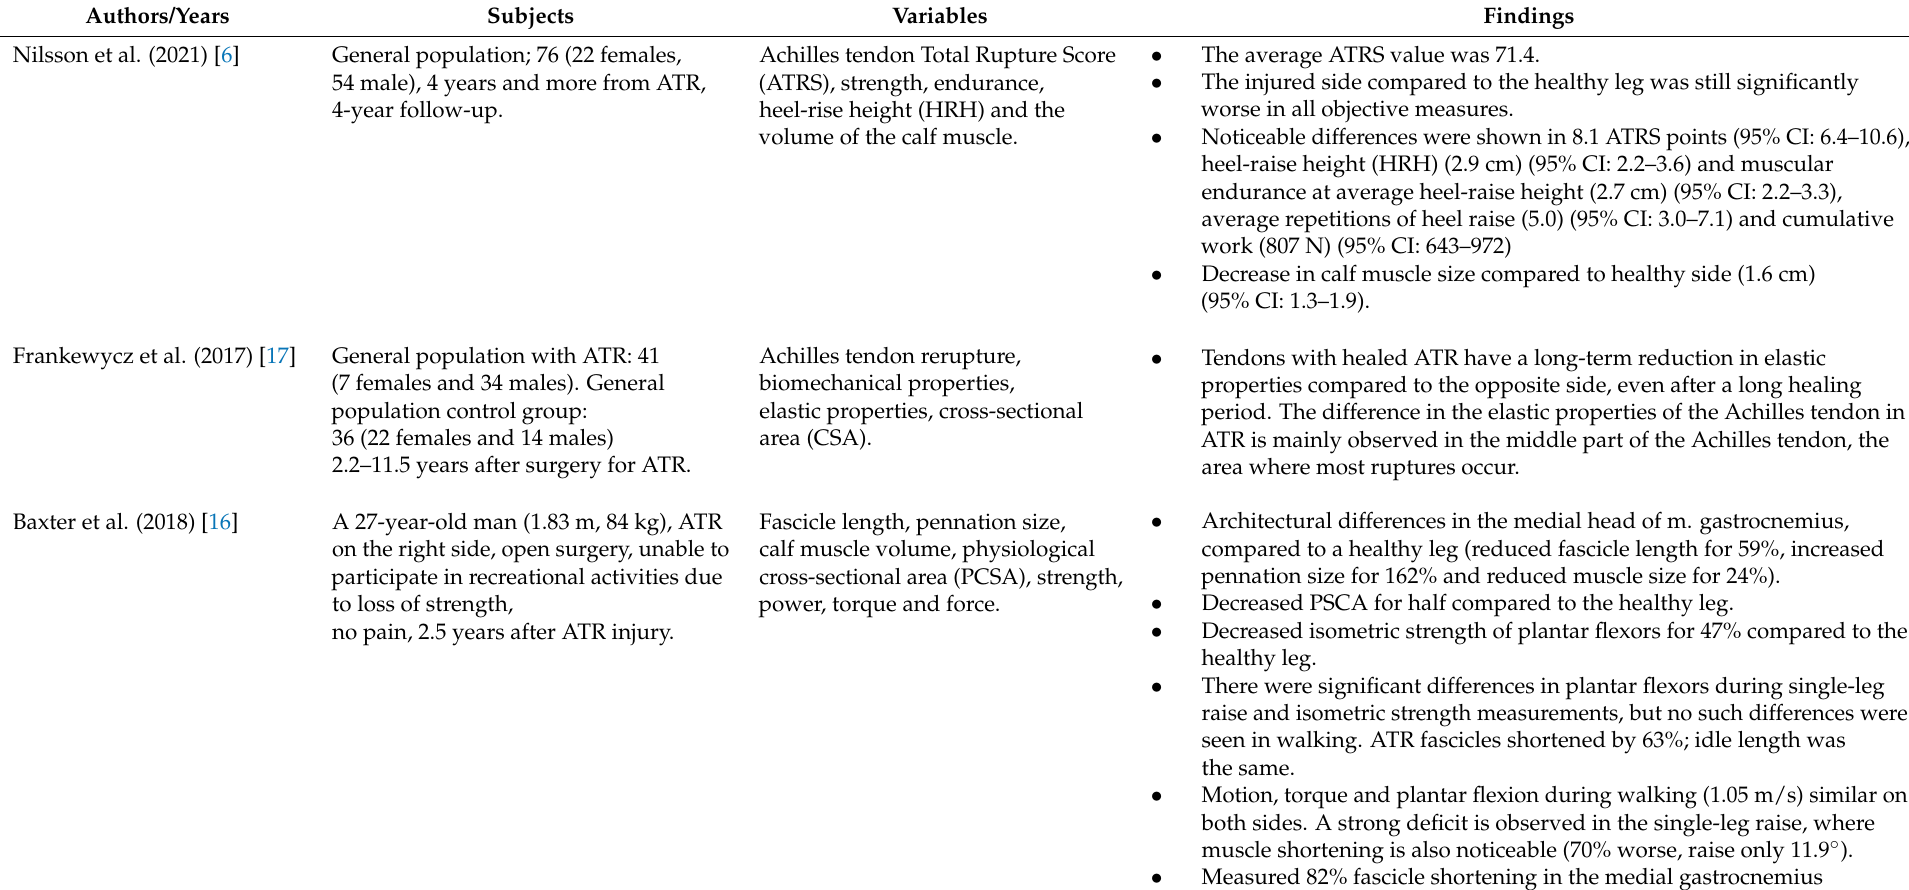
Table 1. Overview of the study